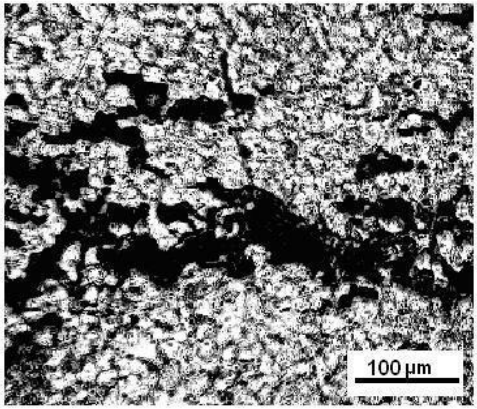
Figure 9: Replica RA10-R3. Macro cracks. Assessment of the microstructure [10]: 5; Assessment of the microstructure [11]: Level B / Level C: Initial spheroidization and carbide precipitation per grain boundary in places with the presence of globular pearlite. 4%